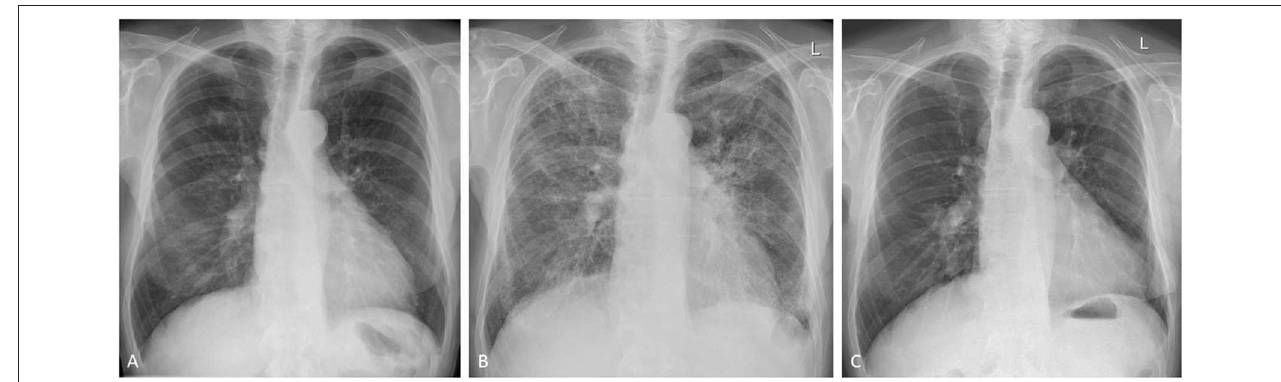
FIGURE 1 | Methotrexate-induced pneumonitis in a 77-year-old man with rheumatoid arthritis. (A) Posterior-anterior chest radiograph immediately before the initiation of treatment. Following 10 days of methotrexate, the patient experienced progressive dyspnea and fever. Follow-up chest radiography showed bilateral heterogeneous opacities in all lung zones. (B) The patient was transferred to the intensive care unit for supportive treatment. High-dose glucocorticoids were administered and gradually withdrawn following clinical and radiological improvement. Initial high-resolution CT scanning showed diffuse infiltrates and bilateral patchy consolidations with only very limited ground-glass opacities (images not shown). (C) Seven months after stopping methotrexate, the changes of pulmonary toxicity had fully